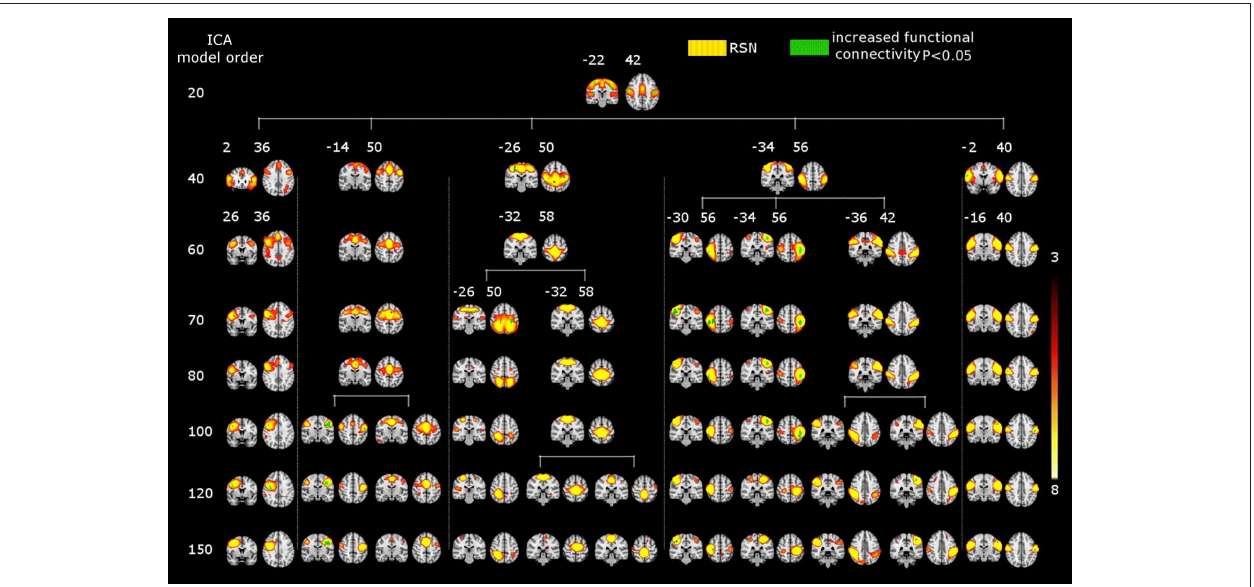
splits into smaller fine-grained sub-networks. Notably, some of these networks still show significant increased connectivity, while others do not. Numbers at the bottom of the images refer to MNI coordinates (xyz). The left hemisphere corresponds to the right side and t-score threshold is shown at